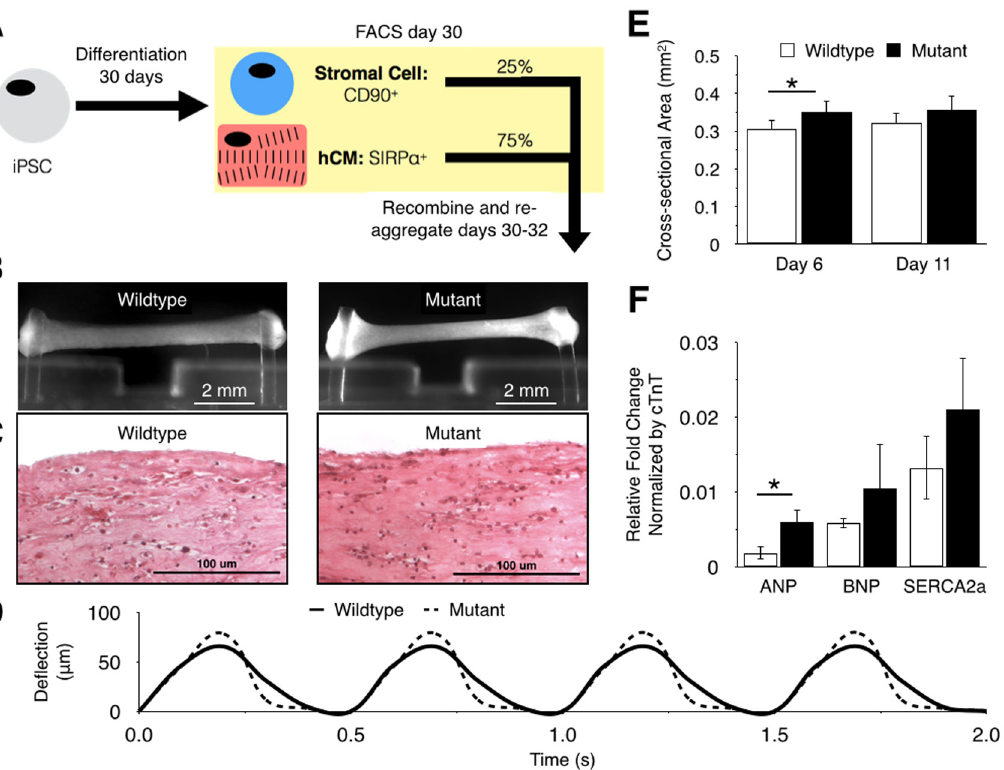
Fig 1. Characterization of wild-type and BRAF iPSC-hECTs. ( A ) Sorting paradigm for construction of defined iPSC-hECTs; ( B ) Photograph of wild-type (left) and mutant (right) tissues after 6 days in culture; ( C ) longitudinal section of wild-type (left) and mutant (right) tissues stained with hematoxylin and eosin after 12 days in culture; ( D ) Post deflections of both tissue types on day 6 at 2 Hz pacing frequency; ( E ) Cross-sectional area (mean ± SD) of wild-type (open bars, n = 7) and mutant (filled bars, n = 4) tissues; ( F ) Molecular analysis of mutant and wild-type tissues performed on day 12 (n = 3 for each tissue